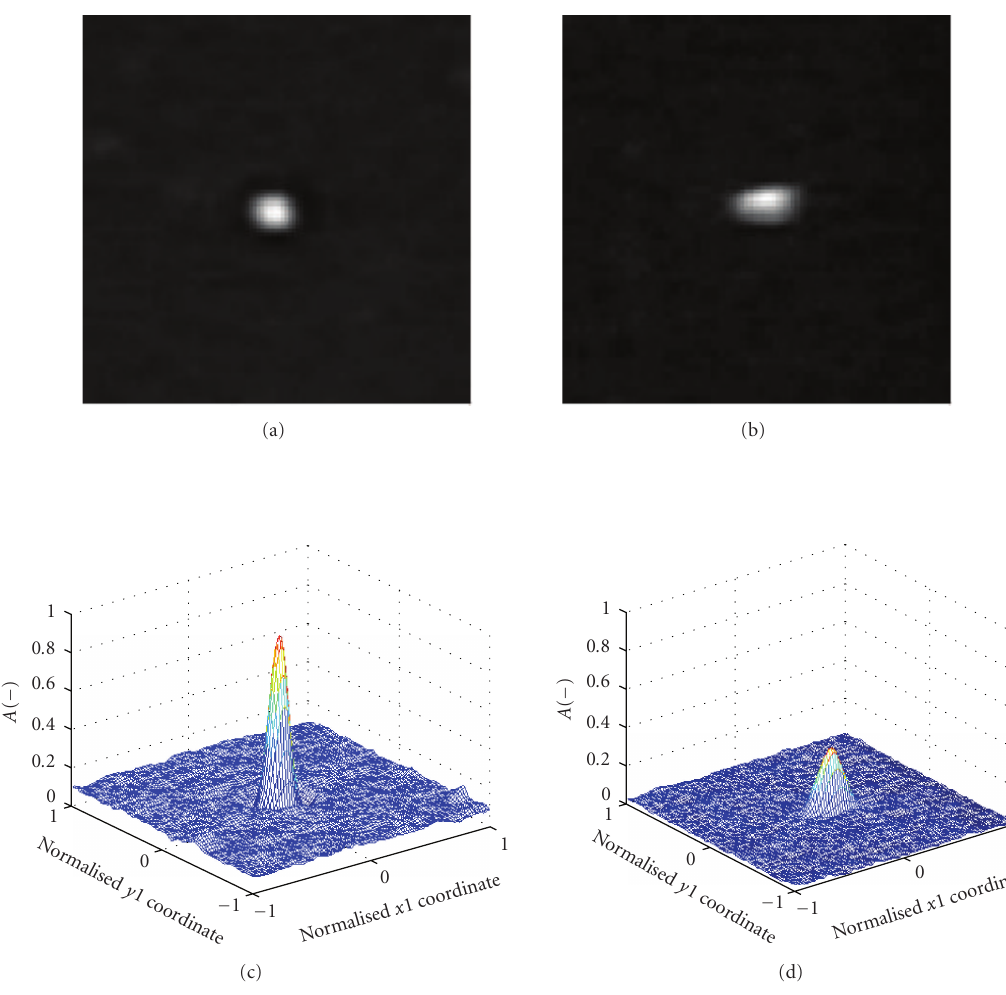
Figure 9: The ellipticity of star profiles (simulation). Profiles of stars also are not circular but rather elliptical, especially for worse objectives and greater distance from the middle of the image. The ellipticity is qualified by sigma x and sigma y (while considering the Gaussian function), where sigma x and sigma y are the distance from the centre of the Gaussian in which the Gaussian is equal to exp( − 0,5) of its central value. Sigma x and sigma y are the major and minor half-axis of the ellipse, perpendicular to each other. The ellipticity in radial direction can significantly grow with the angle distance from the middle of the image, especially for wide-angle images.